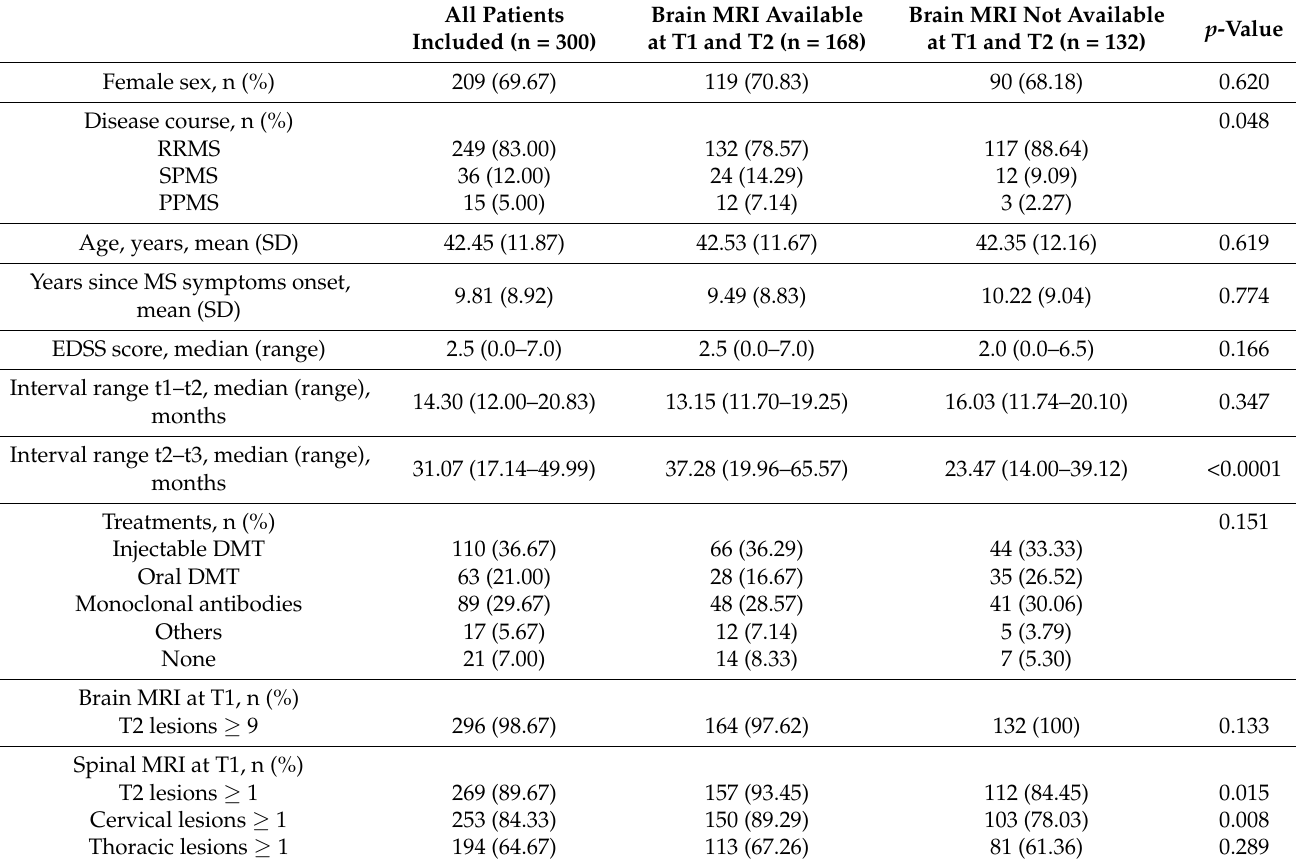
Figure 2. Flow chart of study population. A total of 702 MS patients were screened, 300 fulfilled the inclusion criteria and were therefore considered for analysis. A total of 168 patients also had a brain MRI available within ± 60 days from T1 and T2 (brain MRI subgroup). Table 1. Baseline demographic and clinical characteristics of all patients included in the study (n = 300), those with also available brain MRI within ± 60 days from T1 and T2 (brain MRI-subgroup, n = 168) and those with no available brain MRI within ± 60 days from T1 and T2 (n = 132). The p value refers to the comparison between patients with vs. without brain MRI within ± 60 days from T1 and T2. DMT: disease modifying